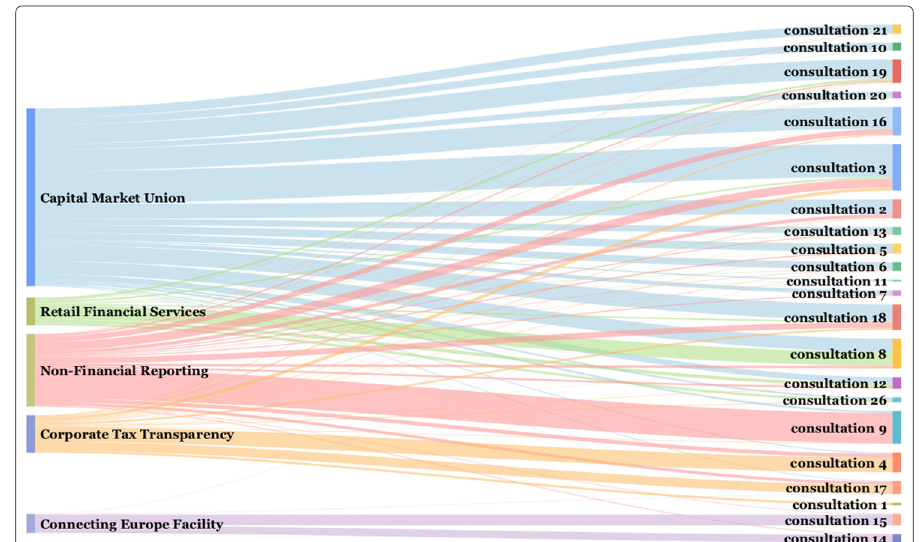
Fig. 2 Relations between the topic communities and consultations. The Sankey diagram links detected topic communities (left-hand side) to the consultations (right-hand side). The thickness of a link corresponds to the number of organizations that responded to a consultation. The diagram clearly shows the overlaps between the topic communities